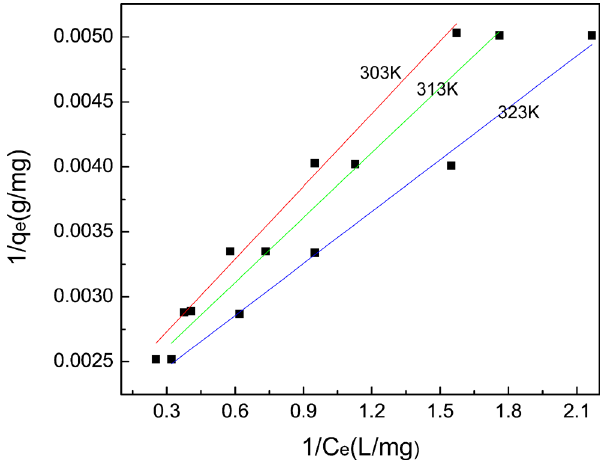
Figure 4: Langmuir isotherms for methylene blue adsorption onto AC at different